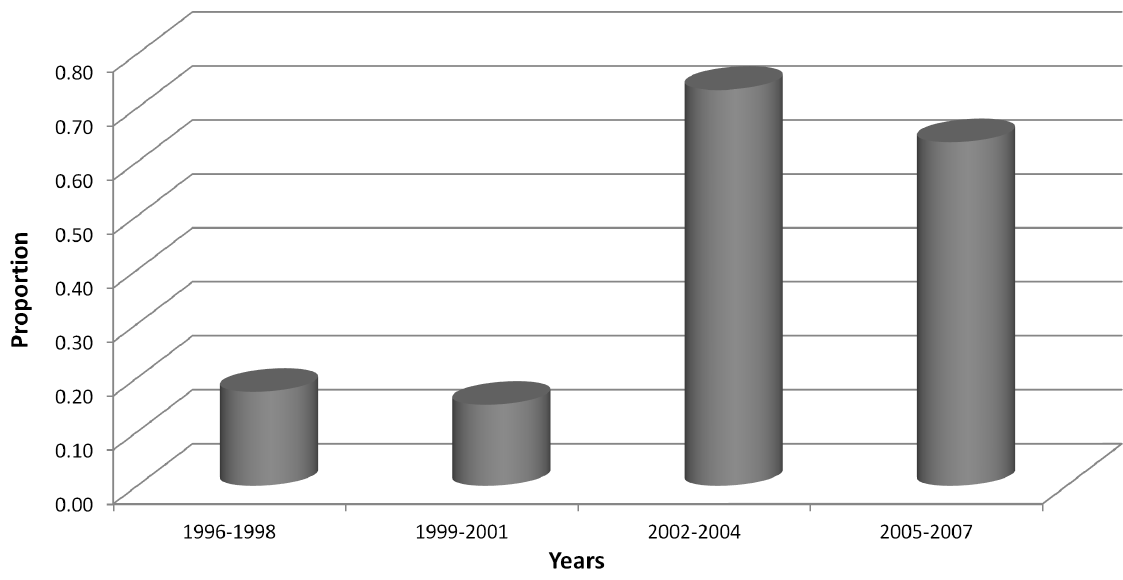
Figure 1. Relative frequency of the HPV-51 genotype in invasive cervical carcinomas from 1996 to 2007.